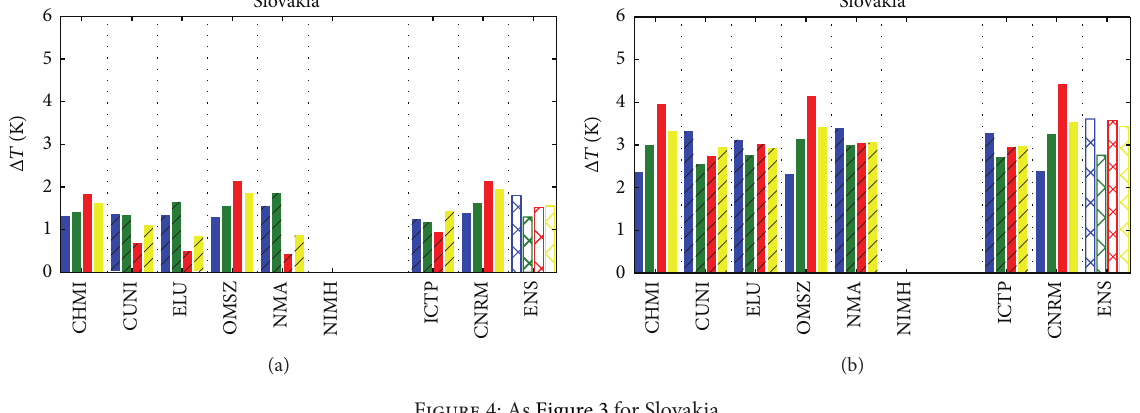
Figure 4: As Figure 3 for Slovakia.